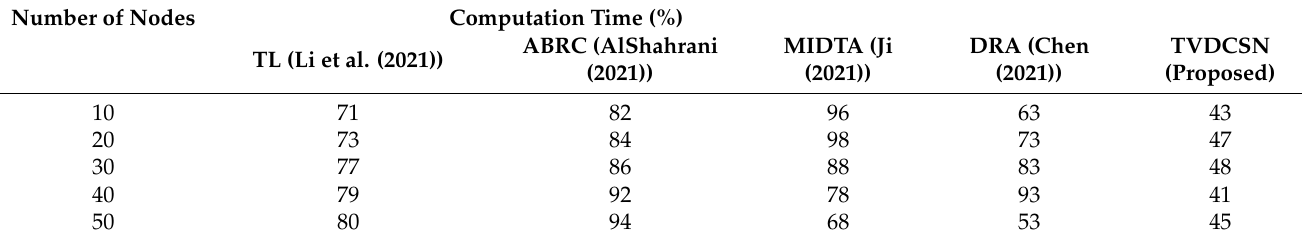
Table 5. Values of proposed and existing methods computation